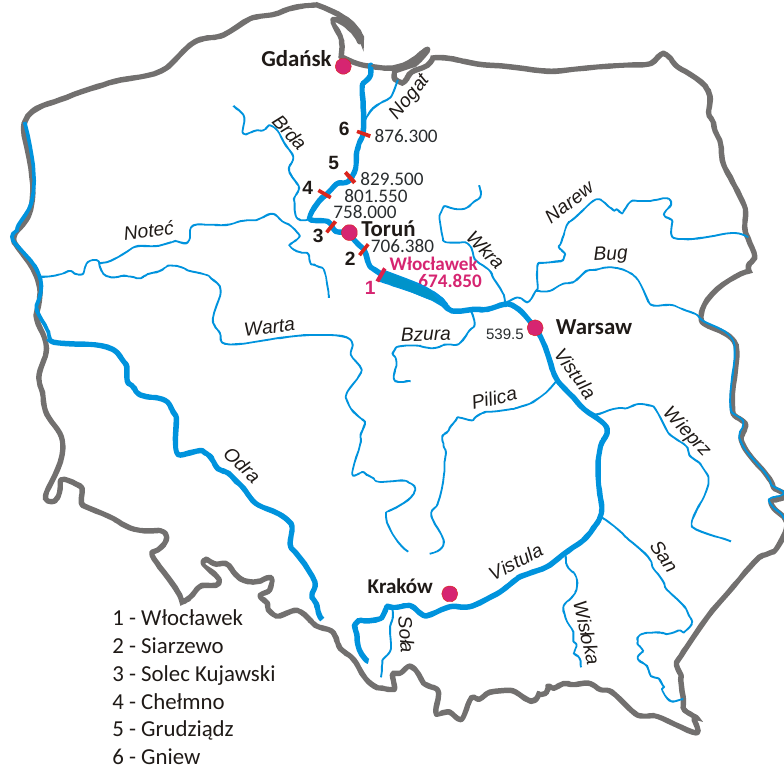
Figure 1. Location of the Włoclawek Dam and proposed further dam locations. Currently, in a section almost 15 km downstream the Włocławek dam (674.850 km), the bottom of the Vistula riverbed is made of hardly erodible deposits, e.g., clay, often covered with moraine paving, and loams (without alluvia). The erosion process is limited here due to the elevation of the bottom material (sand-gravel) downstream and reaching erosion-resistant tertiary loam. From 707 km up to the town of Silno (720 km), the bottom substrate consists solely of sandy formations with a median grain diameter ( d 50 ) of 0.3 to 0.7 mm. In this section, it is difficult to predict the bottom erosion boundary of the stream bed, because the hardly erodible materials are much deeper here. A sand material with such graining at the bottom of the Vistula River will not protect the bed against erosion, when the supply of sediment from the basin and lateral erosion of river banks would become limited. The analysis of the graining of the remains of alluvia in the longitudinal profile of the bed from the dam to Toru´n (734.550 km) shows that they are very diverse. They come from eroded side massifs and clumps and sandbanks, which were formed in the initial phase after the construction of the dam, and the majority of sand is medium and coarse-grained. The entrainment of sand and fine gravel alluvials in the river channel will continue until they are completely